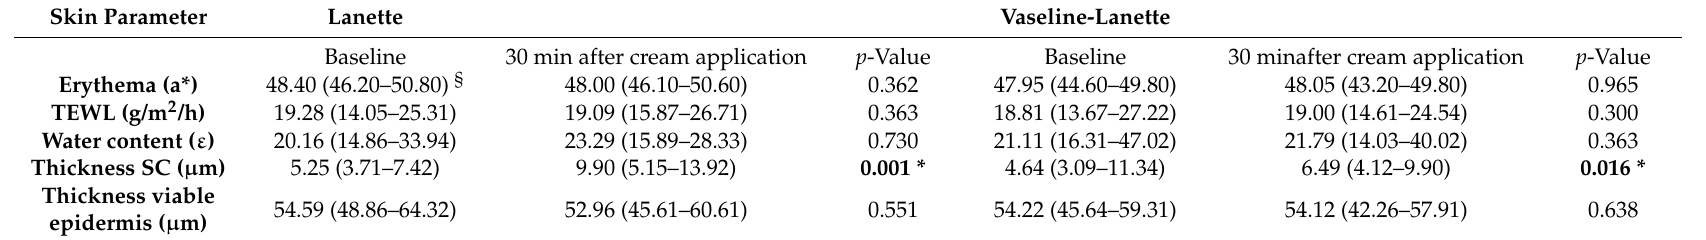
Table 3. Skin parameters measured at baseline and at 30 min after cream